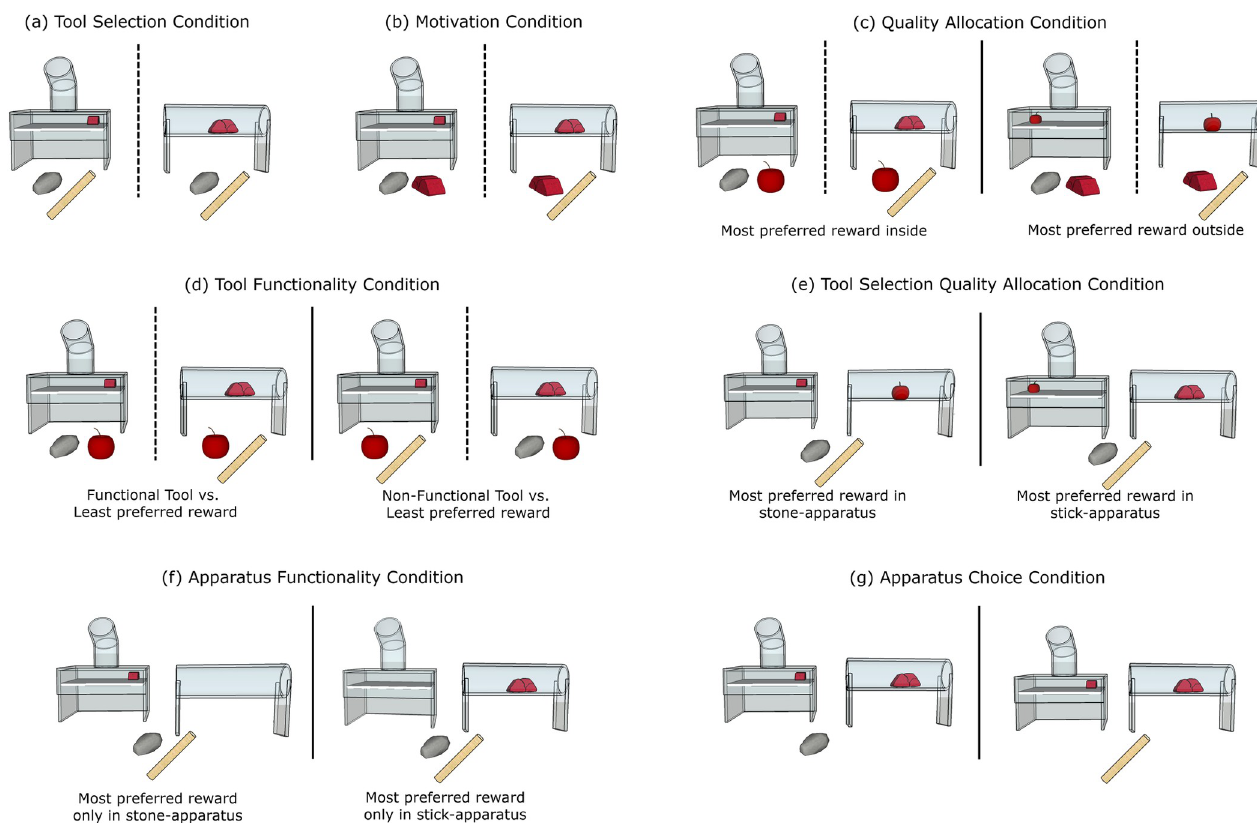
Fig 2. All conditions. (a) Tool Selection Condition: both tools present, most preferred food (MPF) inside: (b) Motivation Condition: functional tool present, MPF inside and outside; (c) Quality Allocation Condition: functional tool present, either MPF inside (left), and the least preferred food (LPF) outside, or MPF outside and LPF inside (right); (d) Tool Functionality Condition: functional tool present (left) or non-functional tool present (right), MPF inside and LPF outside; (e) Tool Selection Quality Allocation Condition: both apparatuses present with both tools, MPF in stone-apparatus (left), or stick-apparatus (right), LPF in other apparatus; (f) Apparatus Functionality Condition: both apparatuses and both tools present, MPF in stone- (left) or stick- (right) apparatus, other apparatus empty; (g) Apparatus Choice Condition: only one (functional) tool is present, both apparatuses presented and baited with MPF.